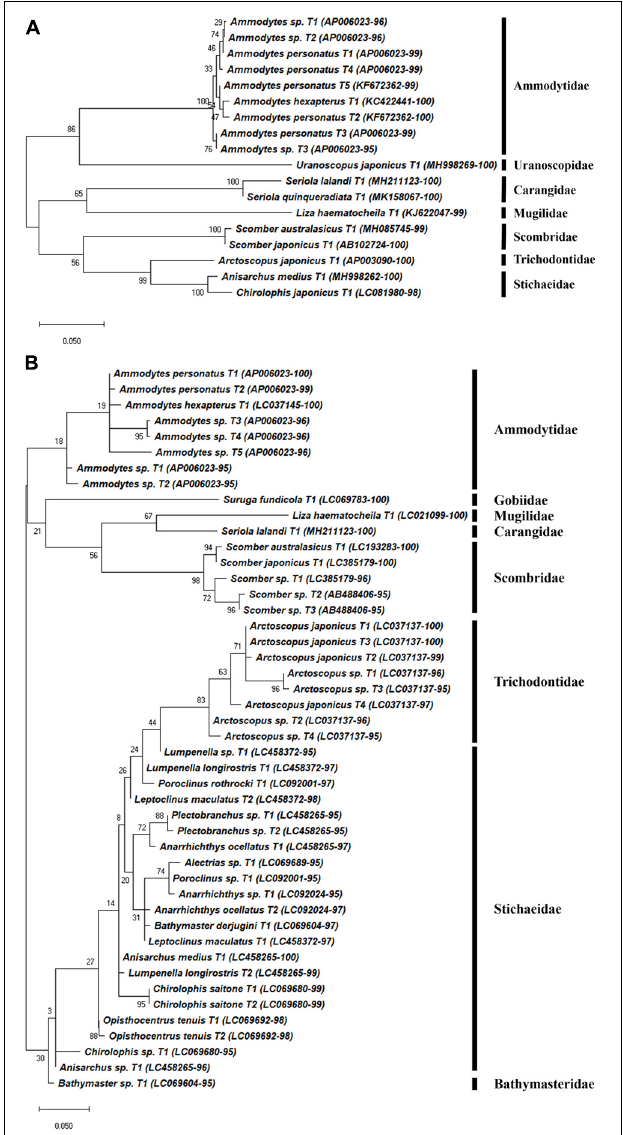
FIGURE 4 | Phylogenetic analysis of representative Perciforms haplotypes generated by (A) FishU primers and (B) MiFish primers in East/Japan Sea, 2016. Phylogenetic tree was constructed by maximum-likelihood algorithm (MEGA-X) under 1000 bootstrap replications.